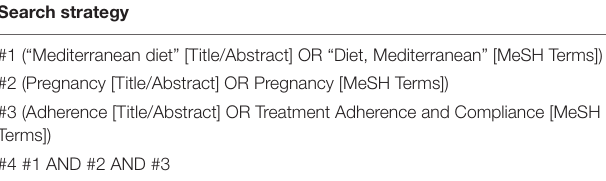
TABLE 1 | Database search strategy.